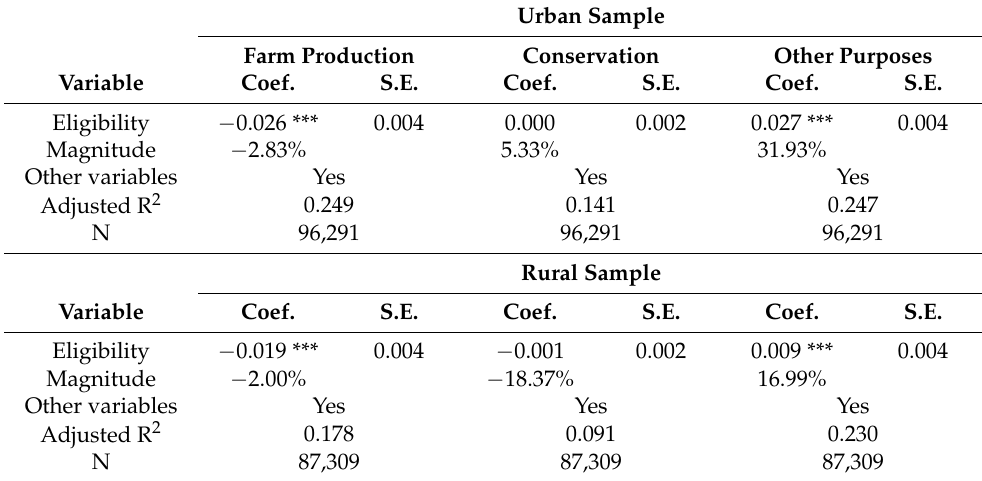
Table 4. Estimation results of the urban and rural sample. Urban Sample Farm Production Conservation Other Purposes Variable Coef. S.E. Coef.